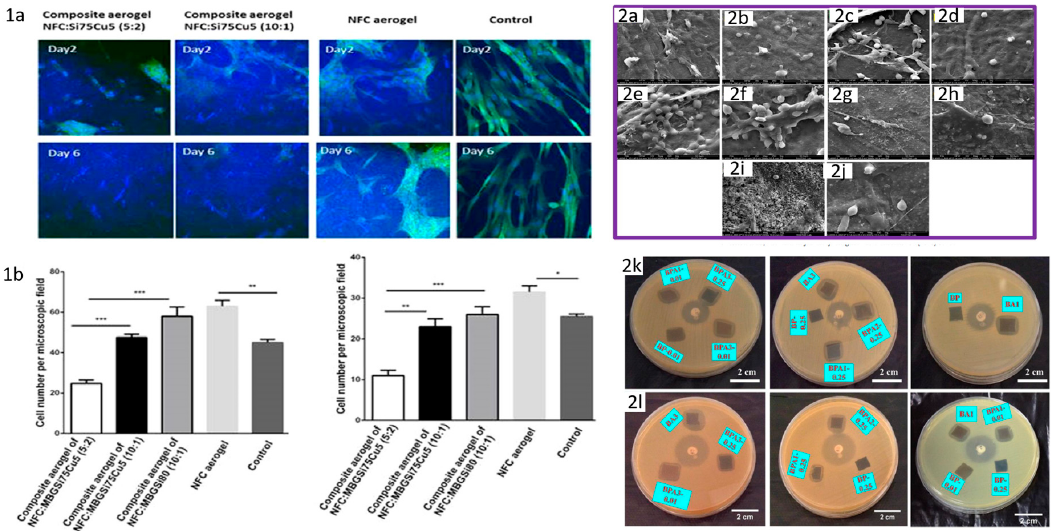
Figure 6. In vitro biological test results for several cellulose-based aerogels: ( 1 ) Representative confocal images of the expression of cytoskeleton marker actin (in green) and nucleus marker 4 ′ ,6-diamidino-2-phenylindole (DAPI) (in blue) for composite aerogels of NFC and mesoporous bioactive glass (MBG) incubated with 3T3 fibroblast cells ( 1a ), and cell proliferation profiles measured after 2 days and 6 days of incubation, * p < 0.1; ** p < 0.01; *** p < 0.001 ( 1b ). Reprinted with permission from [33]. Copyright (2016) Elsevier. ( 2 ) FE-SEM images of cells seeded on pristine bacterial cellulose ( 2a , 2b ) and bacterial cellulose/AgNPs/polyaniline (PANI): bacterial cellulose/PANI aerogel in 0.25 M HCl (BP-0.25) ( 2c , 2d ), bacterial cellulose/AgNPs aerogel (BA3) ( 2e , 2f ), bacterial cellulose/AgNPs/PANI aerogels in 0.01 M HCl (BPA3-0.01) ( 2g , 2h ), and in 0.25 M HCl (BPA3-0.25) ( 2i , 2j ), respectively, after 1 day ( 2a , 2c , 2e , 2g , 2i ) and 7 days ( 2b , 2d , 2f , 2h , 2j ); antibacterial activities of composite aerogels against Staphylococcus aureus ( S. aureus ) ( 2l ) and against Escherichia coli ( E. coli ) ( 2k ), respectively. Reprinted with permission from [172] Copyright (2020)